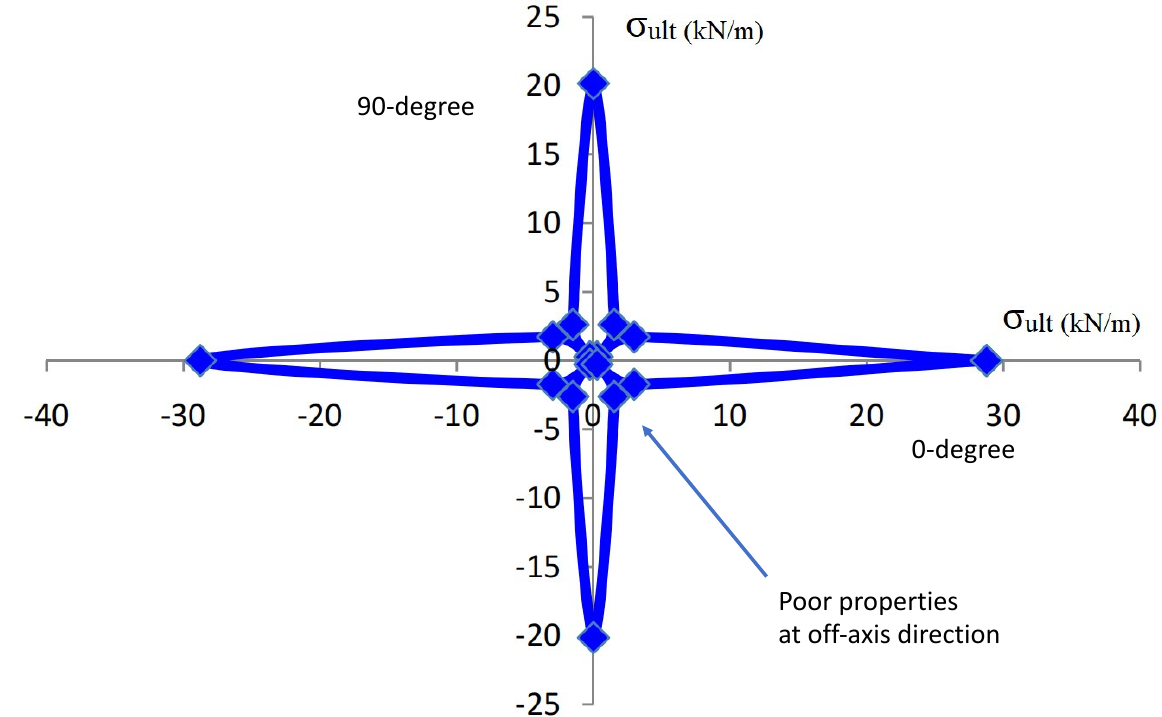
Figure 2. Ultimate tensile strength (kN/m) of tested geogrid specimens around 360 degrees loading directions, ref. [31].